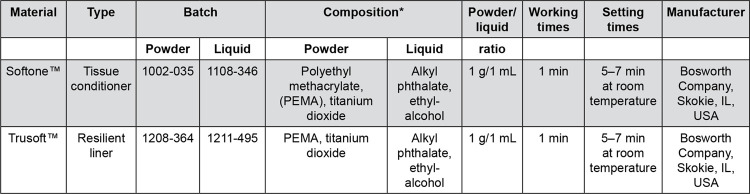
Soft lining materials chosen for this study